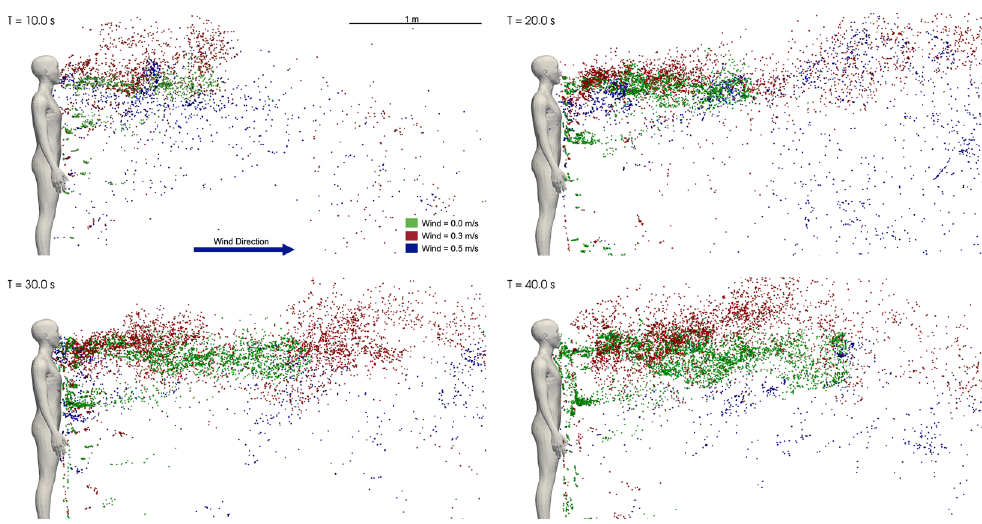
Figure 8. Comparison of droplet dispersion of the quiescent and the rear wind cases at different time instants.